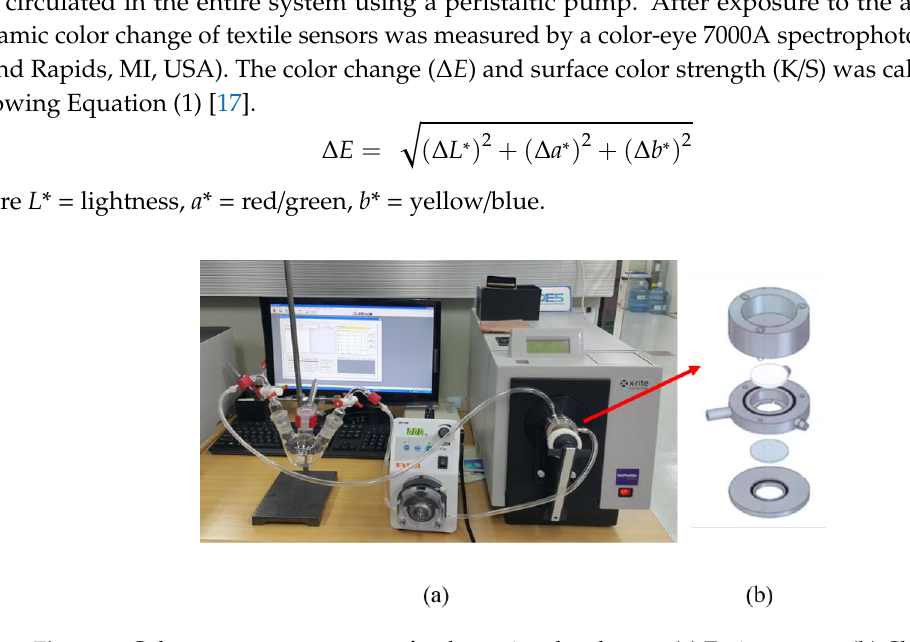
Figure 1. Color measurement system for dynamic color change: ( a ) Entire system; ( b ) Chamber.